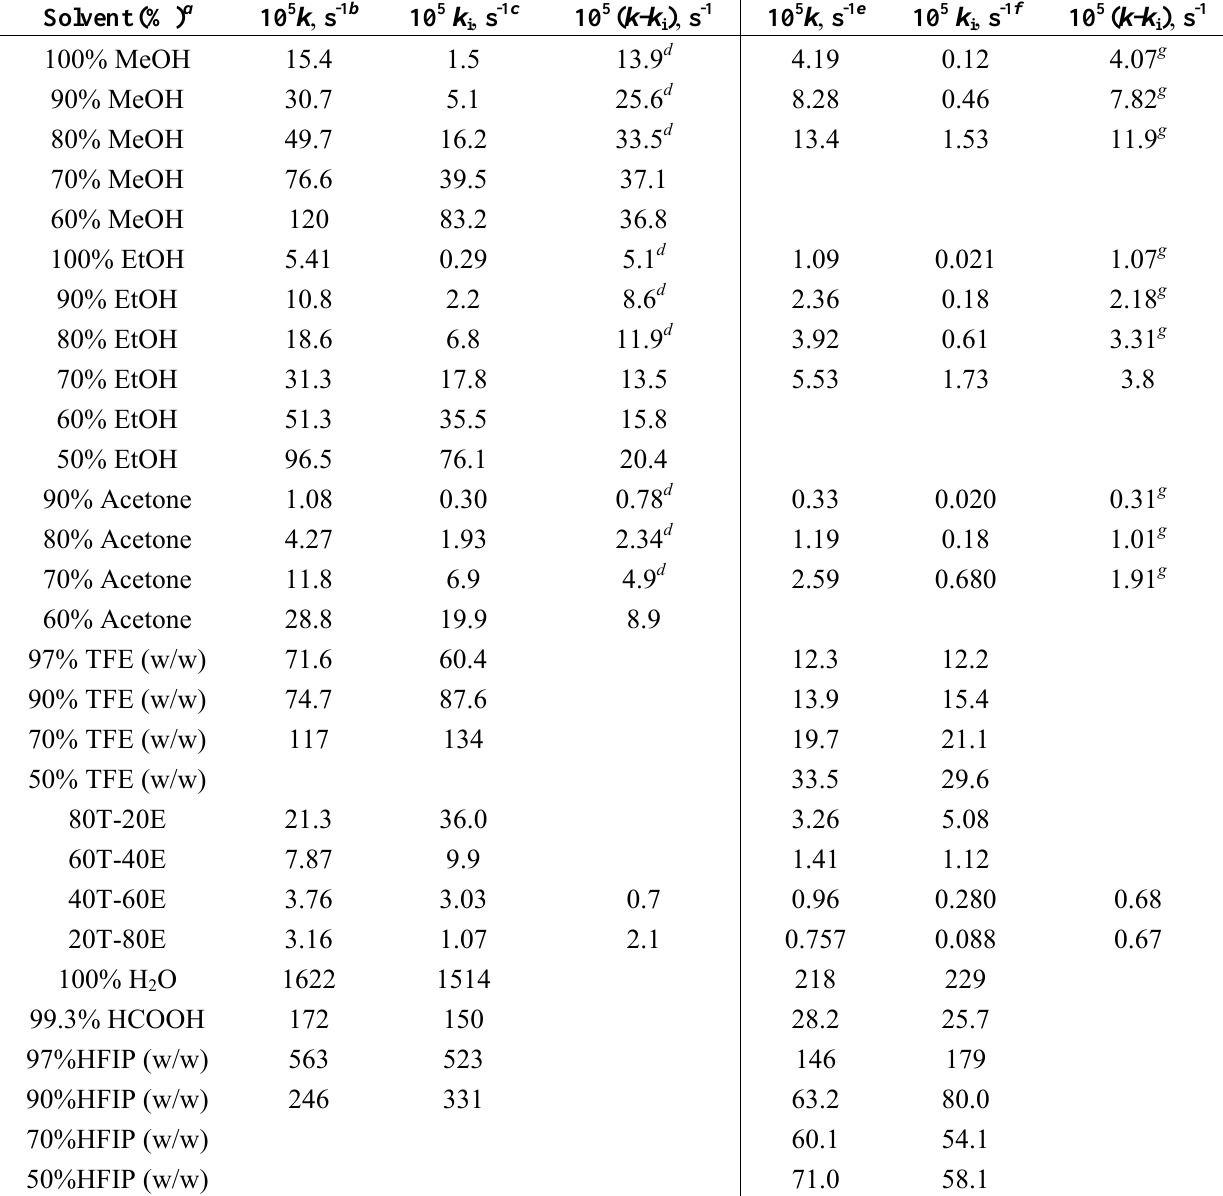
Table 2. Subtraction of the calculated specific rate by the ionization mechanism ( k the experimentally measured specific rates of reaction ( k ) at 40.0 °C and 25.0